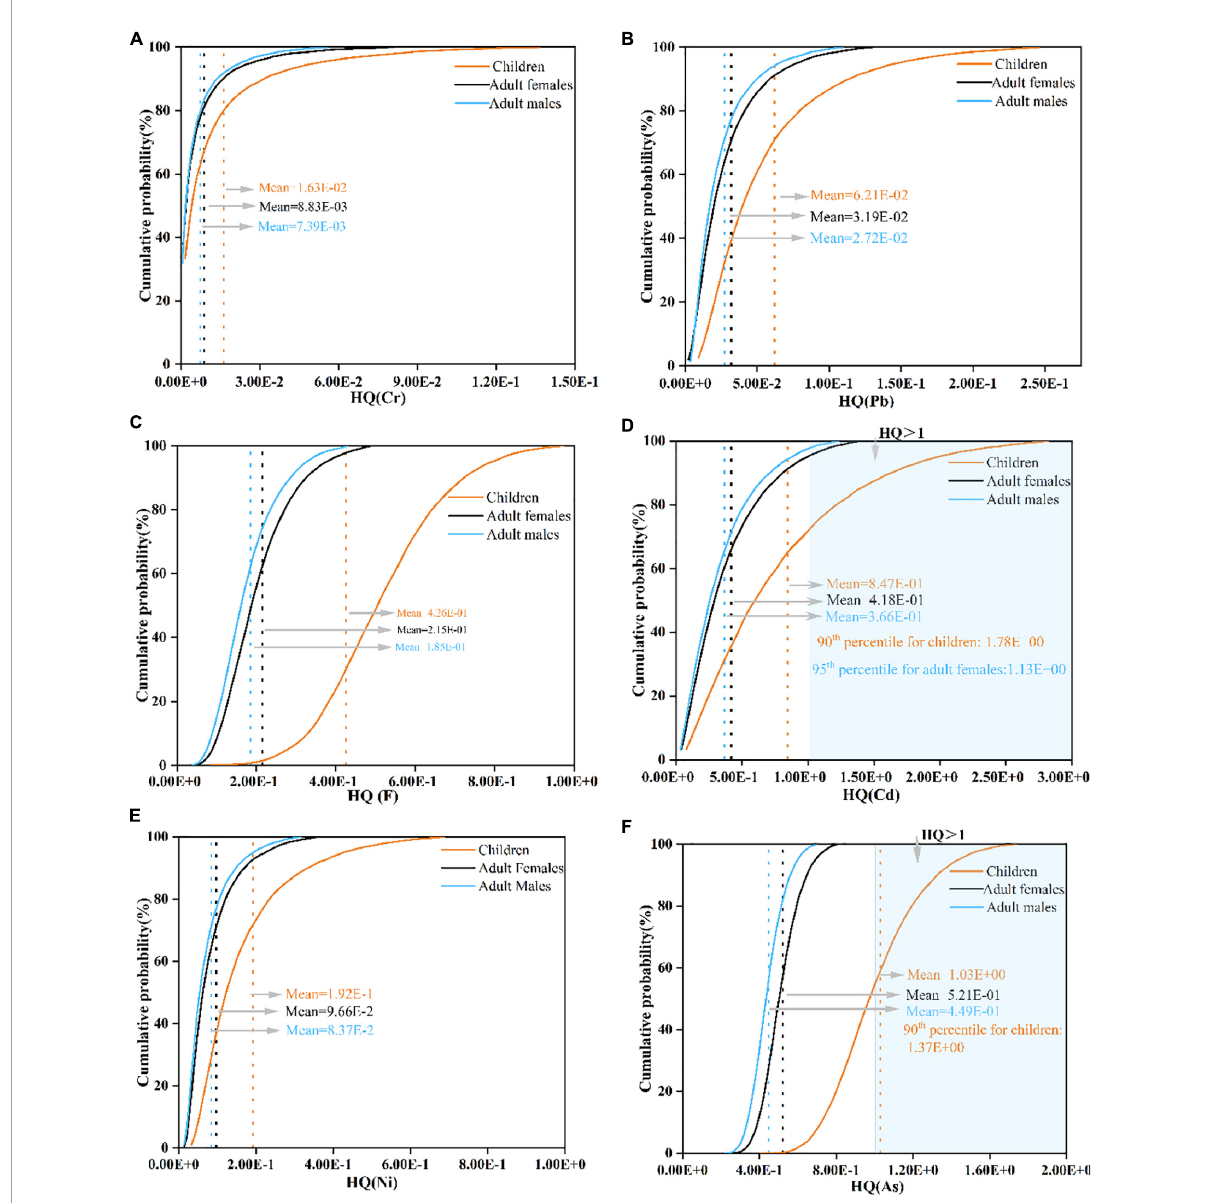
FIGURE4 Cumulative probabilistic distributions of hazard quotient (HQ) for PTE through wheat grain consumption in three populations (children, adult females, and adult males). [ (A) Cr; (B) Pb; (C) F; (D) Cd; (E) Ni; (F)